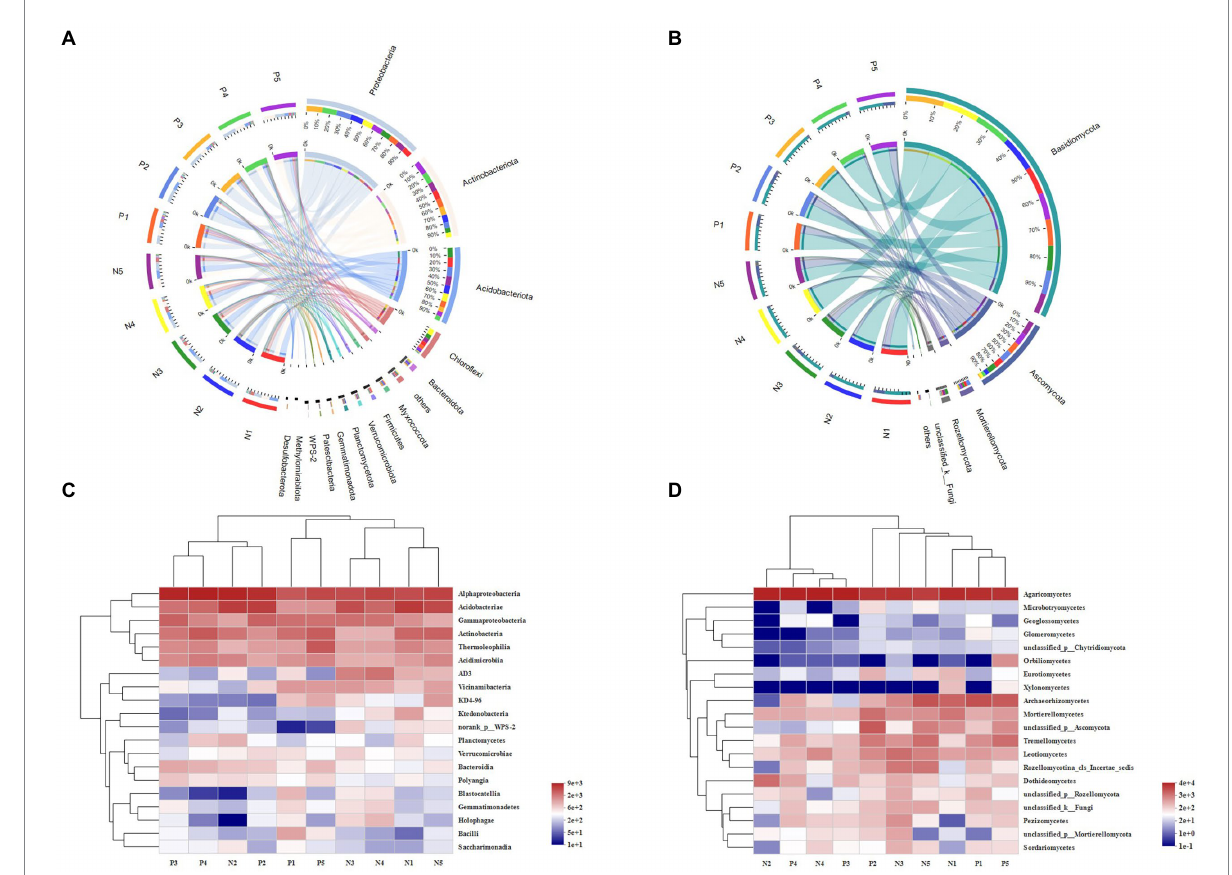
FIGURE 2 The variation of microbial community composition of soil samples across the elevational gradient on Mount Segrila. Circos of (A) bacterial community, and (B) fungal community (OTU level). Heatmap comparison analysis of core microbes based on the (C) bacterial and (D) fungal community composition at class level. P and N represent east slope and west slope, respectively. Different numbers mean different elevations (Number 1, 2, 3, 4, and 5 represent 4,300 m, 4,100 m, 3,900 m, 3,700 m, and 3,500 m,